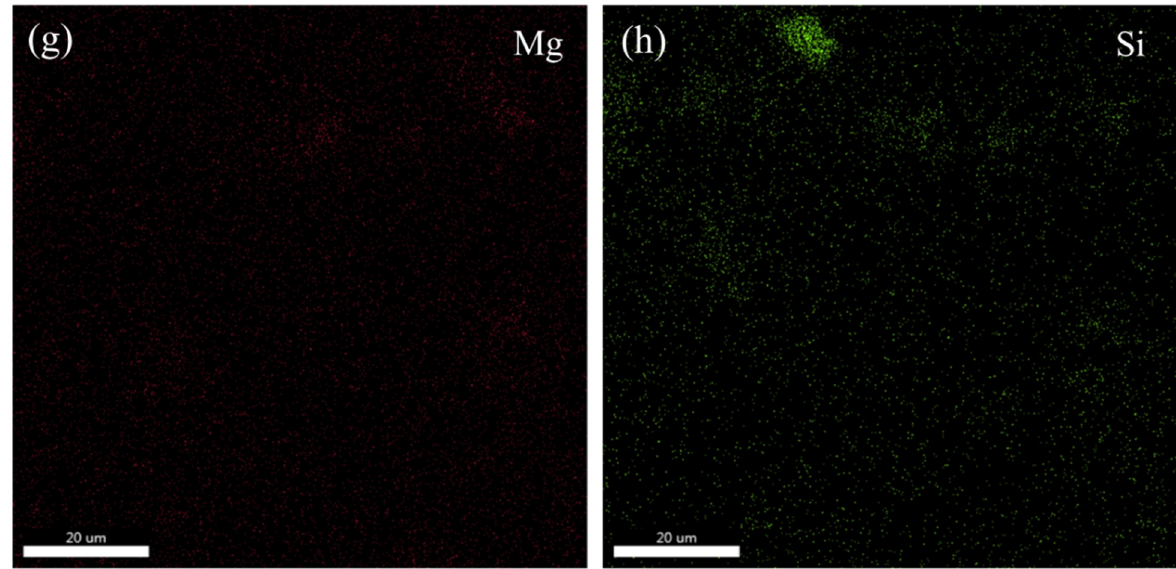
Figure 8. The element maps (core layer) of ( b ) Al, ( c ) Si, ( d ) Mn, ( e ) Fe, and ( f ) Cu of the region in the blue box in ( a ). In addition, ( g ) Mg and ( h ) Si in the red box in ( a ) (cold-rolled state).